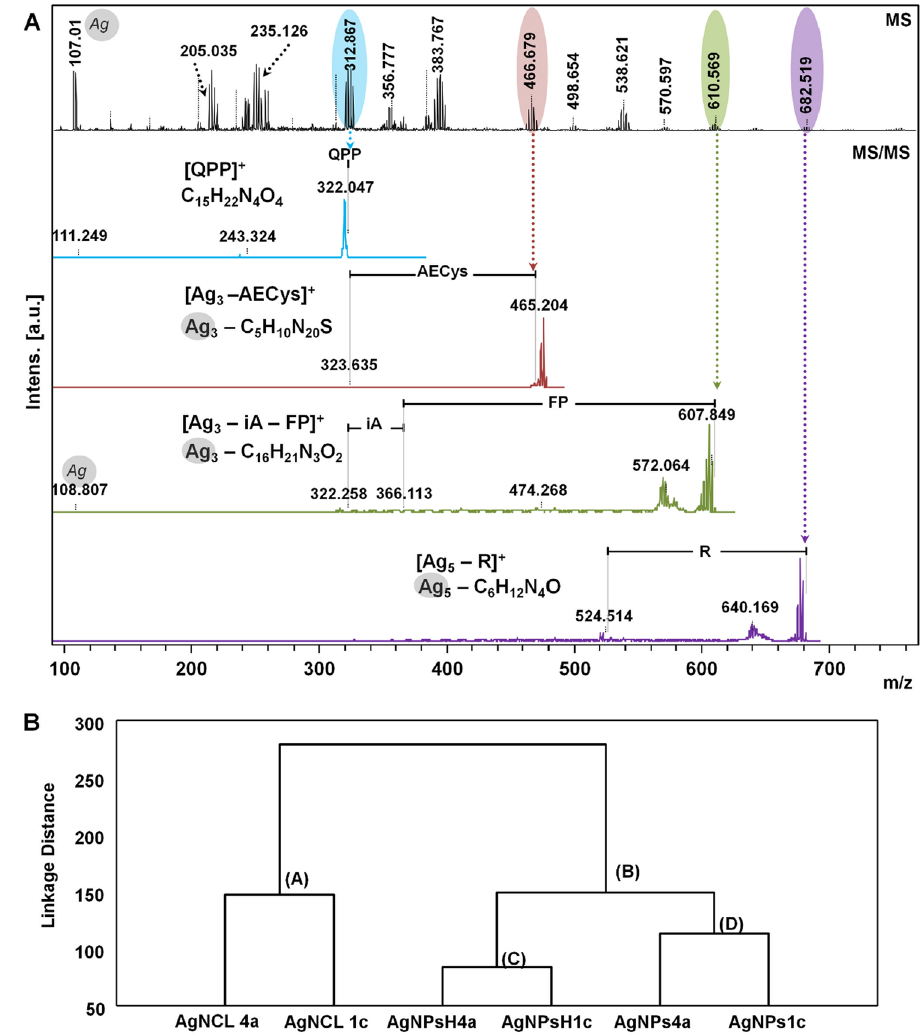
Fig. 10 An example of MS/ MS spectra A of the metal– organic signals and hierarchi- cal cluster analysis B present- ing dissimilarity based on the (Bio)NCs